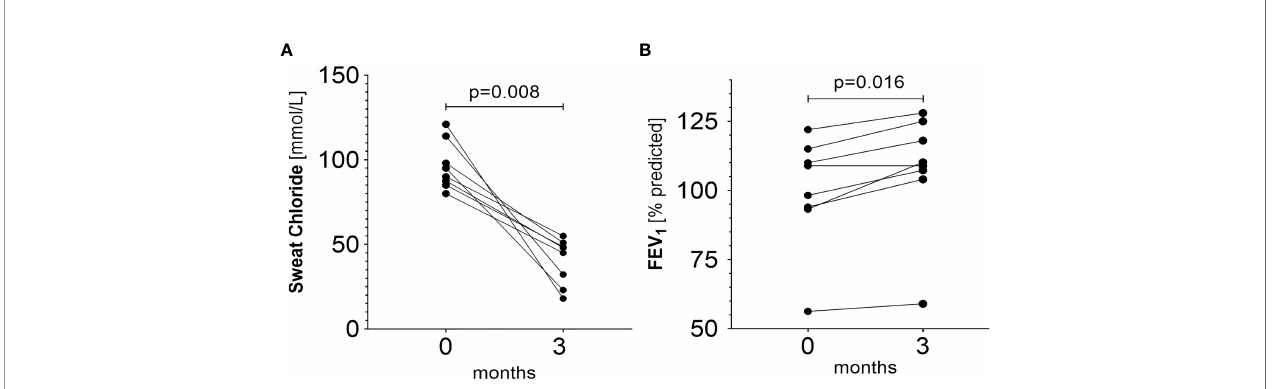
FIGURE 5 | (A) Changes in sweat chloride prior to and during ivacaftor therapy (p = 0.008). Baseline mean: 96.31 ± 14.34 (median: 92.50, IQR=24.38) mmol/L. Mean after three months of therapy initiation: 40.10 ± 13.85 (median: 46.50, IQR=25.10) mmol/L. (B) Changes in FEV 1 prior and during ivacaftor therapy (p=0.016). Baseline mean: 99.7 ± 20.3% predicted, (median: 103.6% predicted, IQR=20.4% predicted). Mean after three months of therapy initiation: 107.6 ± 21.4%pred (median: 109.6% predicted,